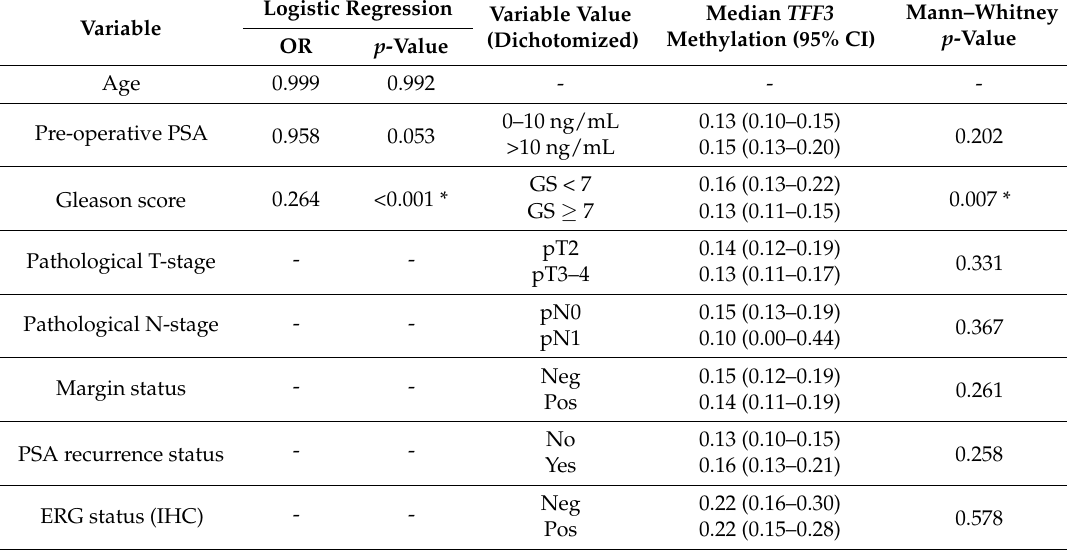
Table 2. Correlation between TFF3 promoter methylation (CpG sites Nos. 6–8) and clinicopathological variables in RP samples ( n = 292). Abbreviations: OR, odds ratio; CI, confidence